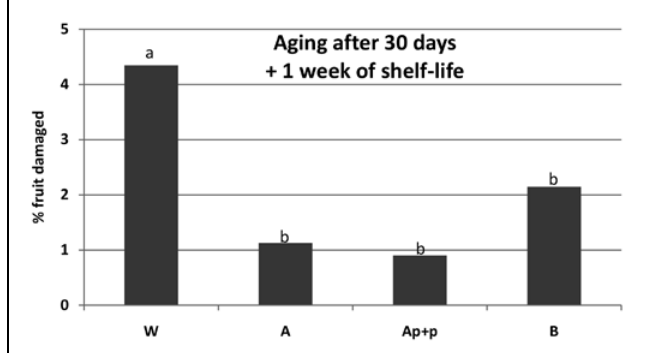
Fig. 3 - Effect of treatments on aging percentage on clementine, after 30 days of storage at 6±1°C followed by one week at 20±2°C. Each treatment was applied to three replicates of 200 fruits each. Water treatment was used as control. Columns marked with the same letters are not statistically different according to Tukey’s test (P = 0.05). W= Water control, preharvest treatments; A= Potassium phos- phite, preharvest treatments (2.5 g/L); Ap+p= Potassium phos- phite, pre- (2.5 g/L) and postharvest treatments (4 g a.i./L); B= Phosetyl-Al, preharvest treatments (2.5